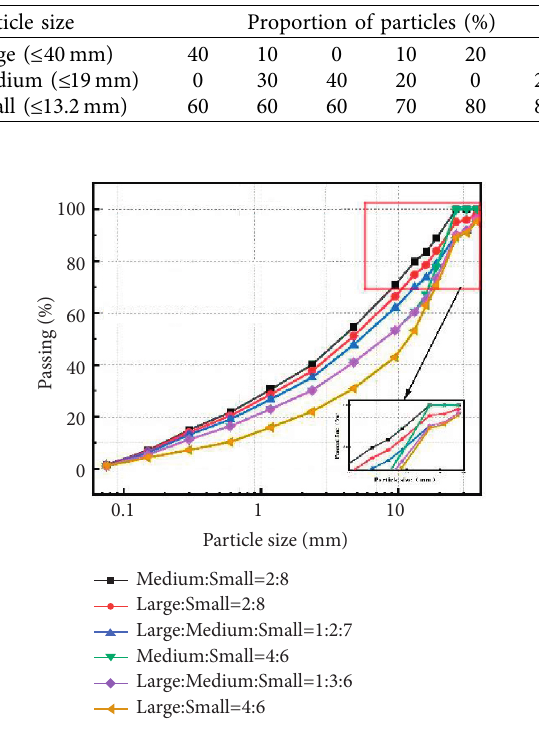
Figure 3: Sieving test of different